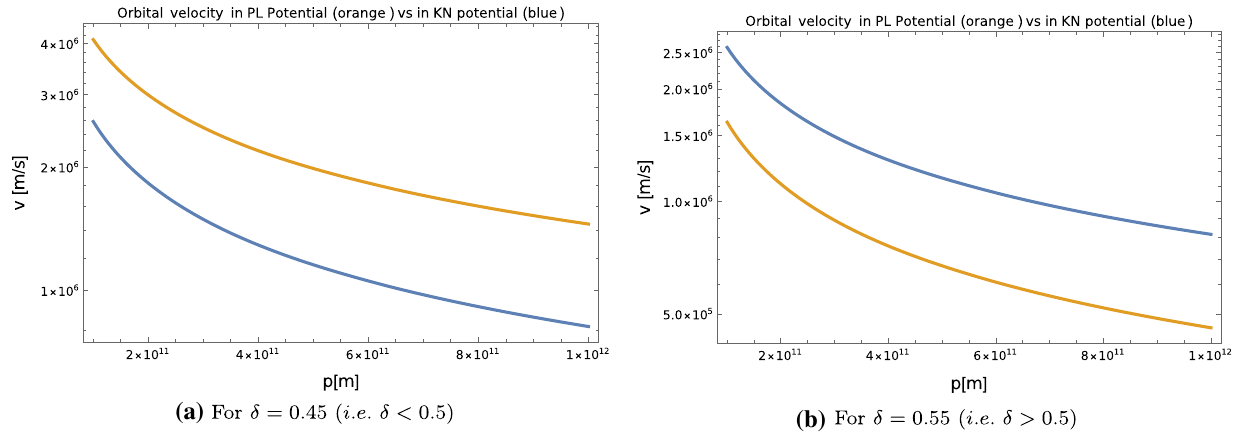
Fig. 1 Figureshowsvelocityofthesmallerobjectintheextrememassratiobinaryinpowerlaw(PL)potential(orangecurve)andinKepler–Newton (KN) potential (blue curve) with respect to radial distance between the two bodies